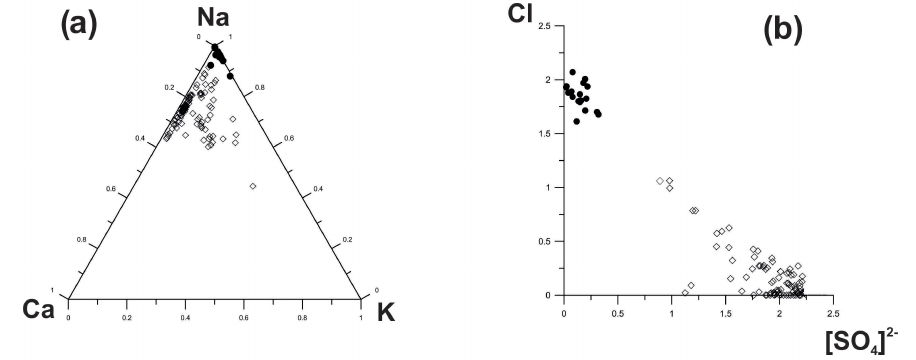
Figure 8. Ratios of major extra-framework cations and anions in sodalite (black circles) and hauyne (blank rhombs) from the Arsenatnaya